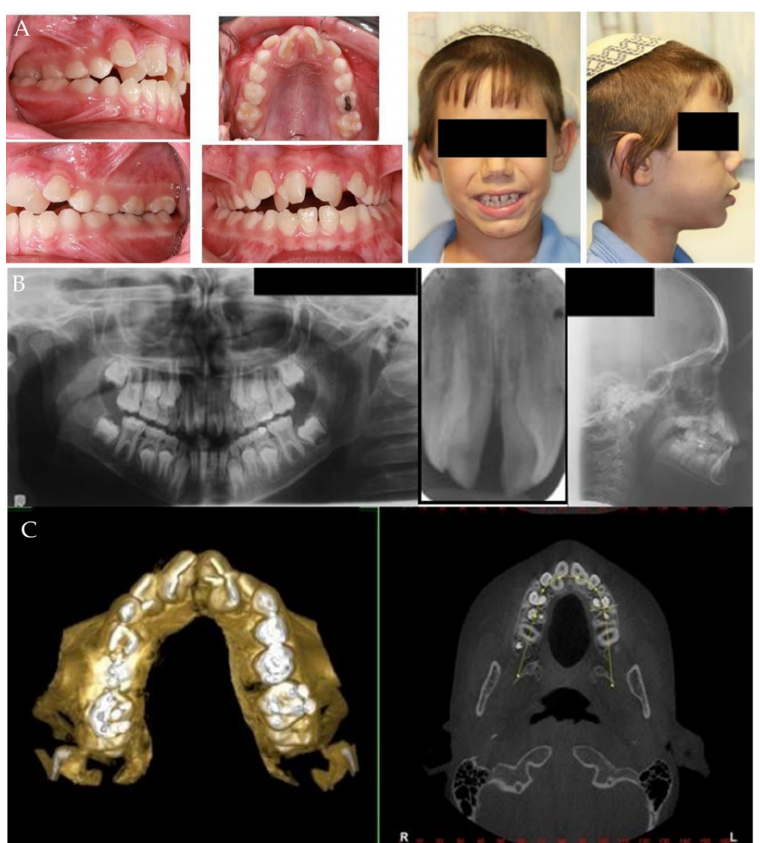
Figure 1. Geminated upper central incisors, a clinical and radiographic view before treatment. ( A ) Intraoral and extraoral view; ( B ) panoramic, periapical and cephalometric radiographs; ( C ) Cone Beam Computerized Tomography (CBCT) of geminated teeth.